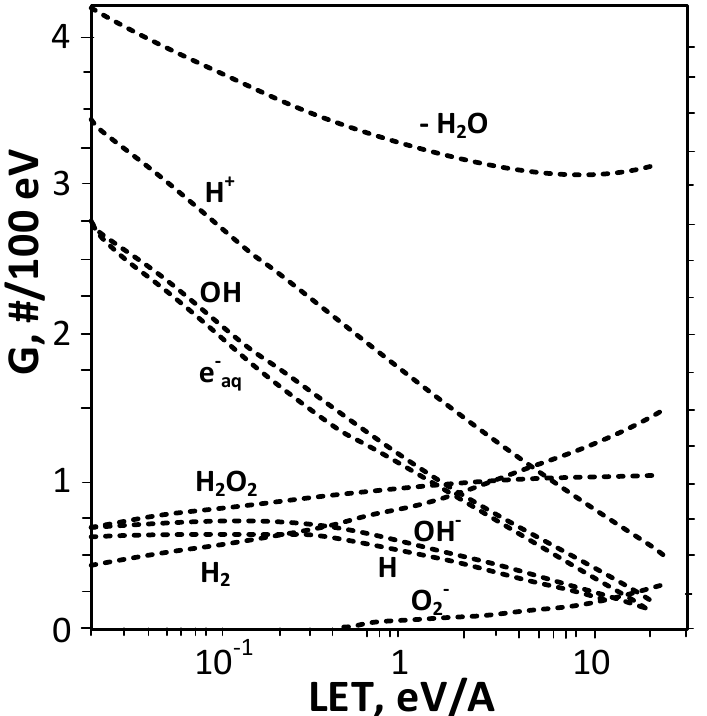
Figure 20. G-values for various radiolysis products as a function of LET (after Kritsky et al. [27]). ©2001 ITER Organization. This image is hereby used courtesy of the ITER Organization.